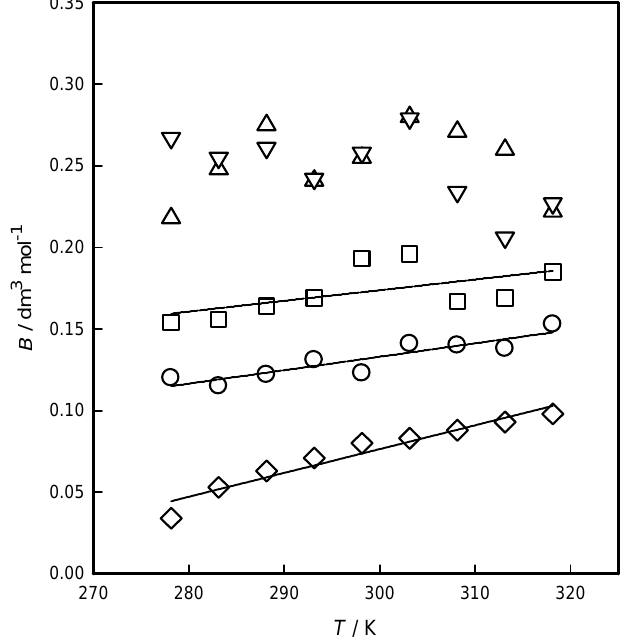
Figure S2. Temperature dependence of the viscosity B -coefficients for NaCl in water–1,4- dioxane mixtures. Points: x = 0.00 ( ◊ ) (Ref. 2. in the manuscript), x D x = 0.15 ( D ) , and x = 0.20 ( (cid:209) ) . Lines are linear fits; from their slopes d B /d T values are D D determined at x = 0.05 and x = 0.10. Polynomial fits for x D D out due to the scattering of the